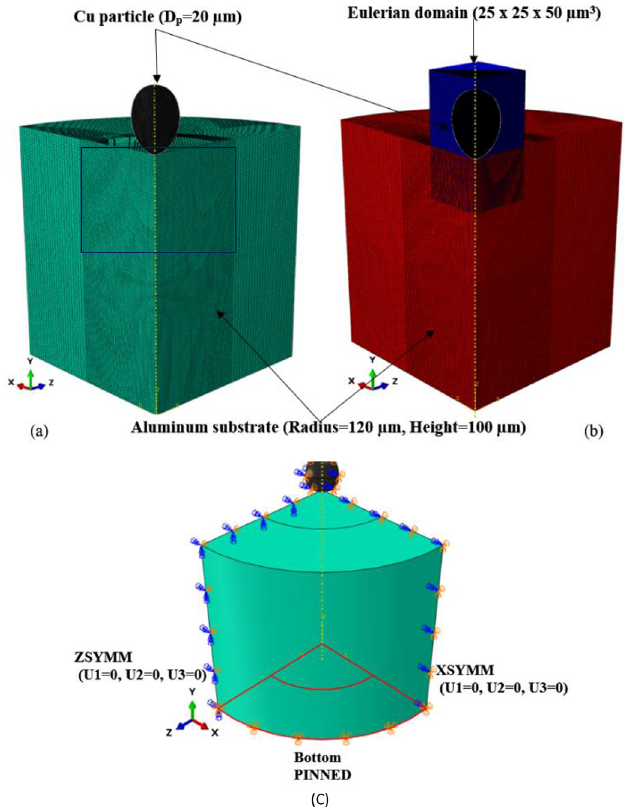
Fig. 1. Schematic diagram illustrating 3D model used is this study for (a) Lagrangian, SPH and ALE method (b) CEL approach (c) Boundary conditions for the 3D